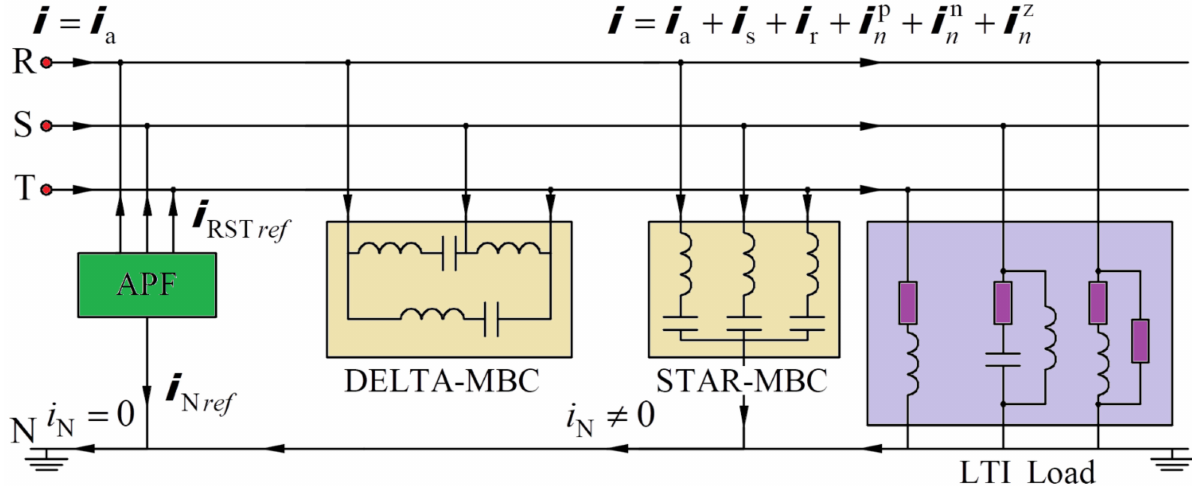
Figure 7. The analyzed system with connected the minimizing balancing compensators (MBC) and the active power filter